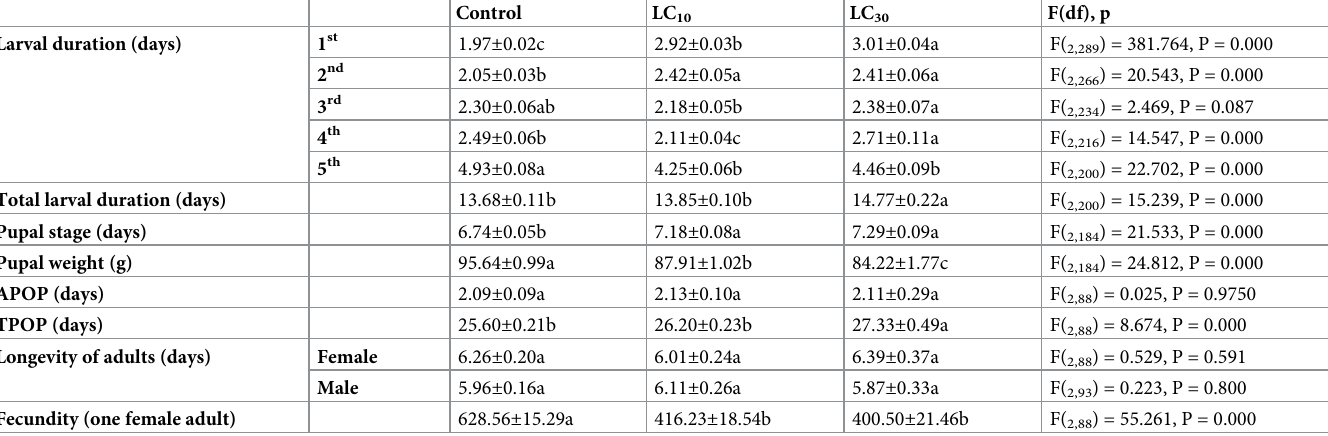
Table 1. Effects of TCAP on the development, pupal weight, longevity, and fecundity of S . exigua .